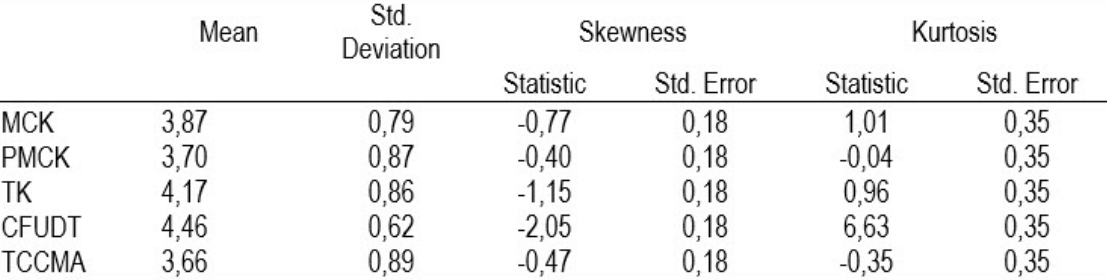
Descriptive data on the five scales of adjusted TPACK-TCCMA